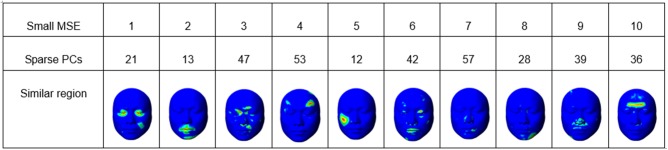
The regions with high similarity between F2 and F53 by SPCA sparse principal components.